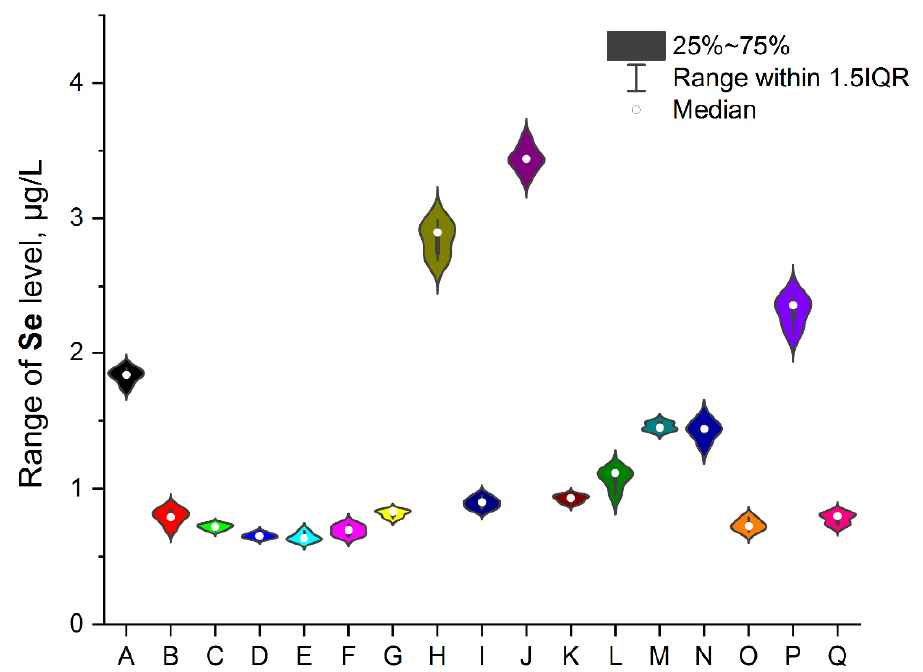
Figure 6. The plot as a violin with the box for the Se level ( µ g/L) in the examined products